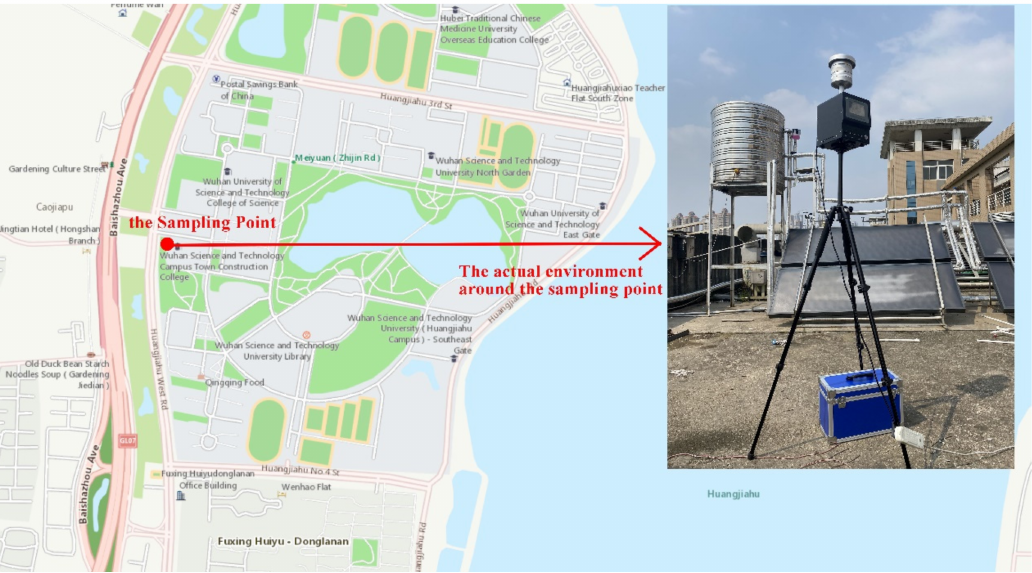
Figure 1. The specific orientation of the sampling